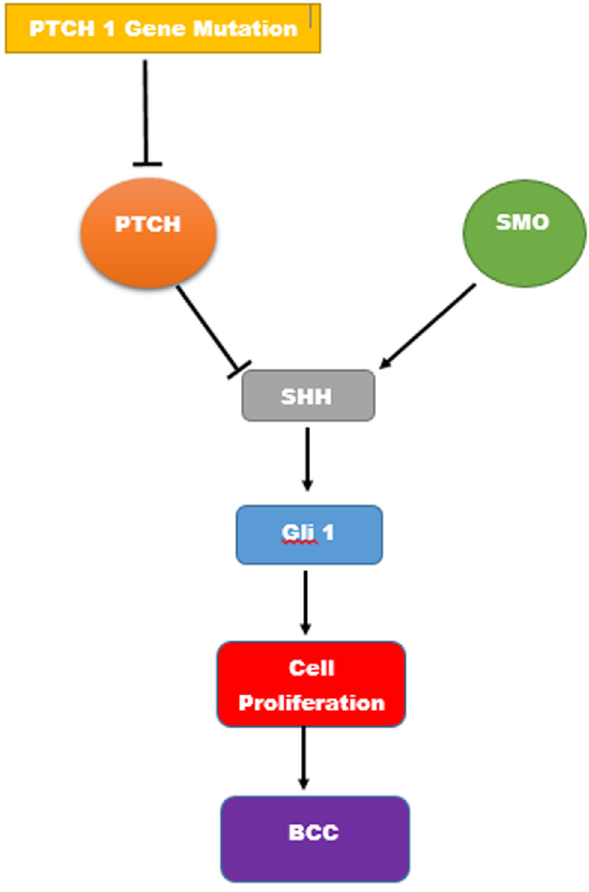
Figure 2: Interactions between Shh, Ptch - 1, and Gli -